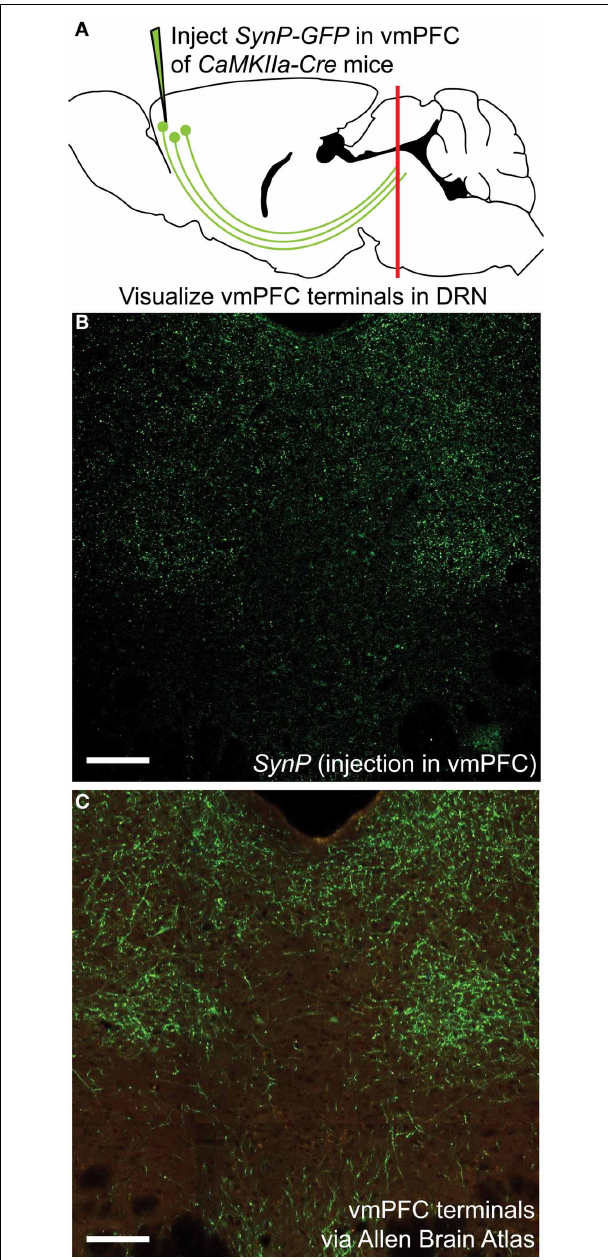
FIGURE 1 | VisualizationofvmPFCaxonterminalsintheDRN(A) AnAAV vector coding for the Cre -dependent expression of the fluorescently tagged synaptic protein Synaptophysin ( SynP-GFP ) was injected in the vmPFC of CaMKIIa-Cre mice. Topographic distribution of vmPFC axon terminals in the DRN was visualized using confocal microscopy. (B) Distribution of vmPFC terminals as determined by SynP-GFP expression as reported in this